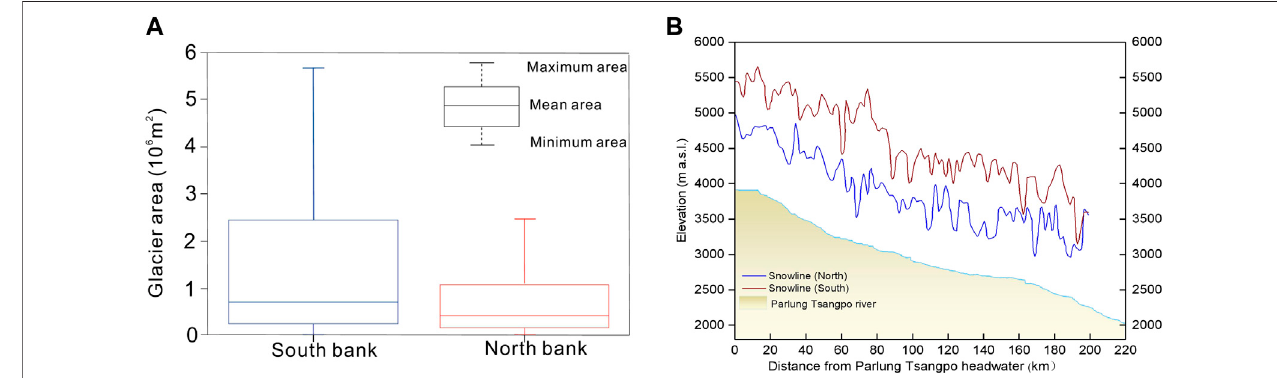
FIGURE 12 | (A) Glacier area distribution on north and south banks of Parlung Tsangpo river. (B) Characteristics of the snow-line of the North- and South-Facing slope along the Parlung Tsangpo river.